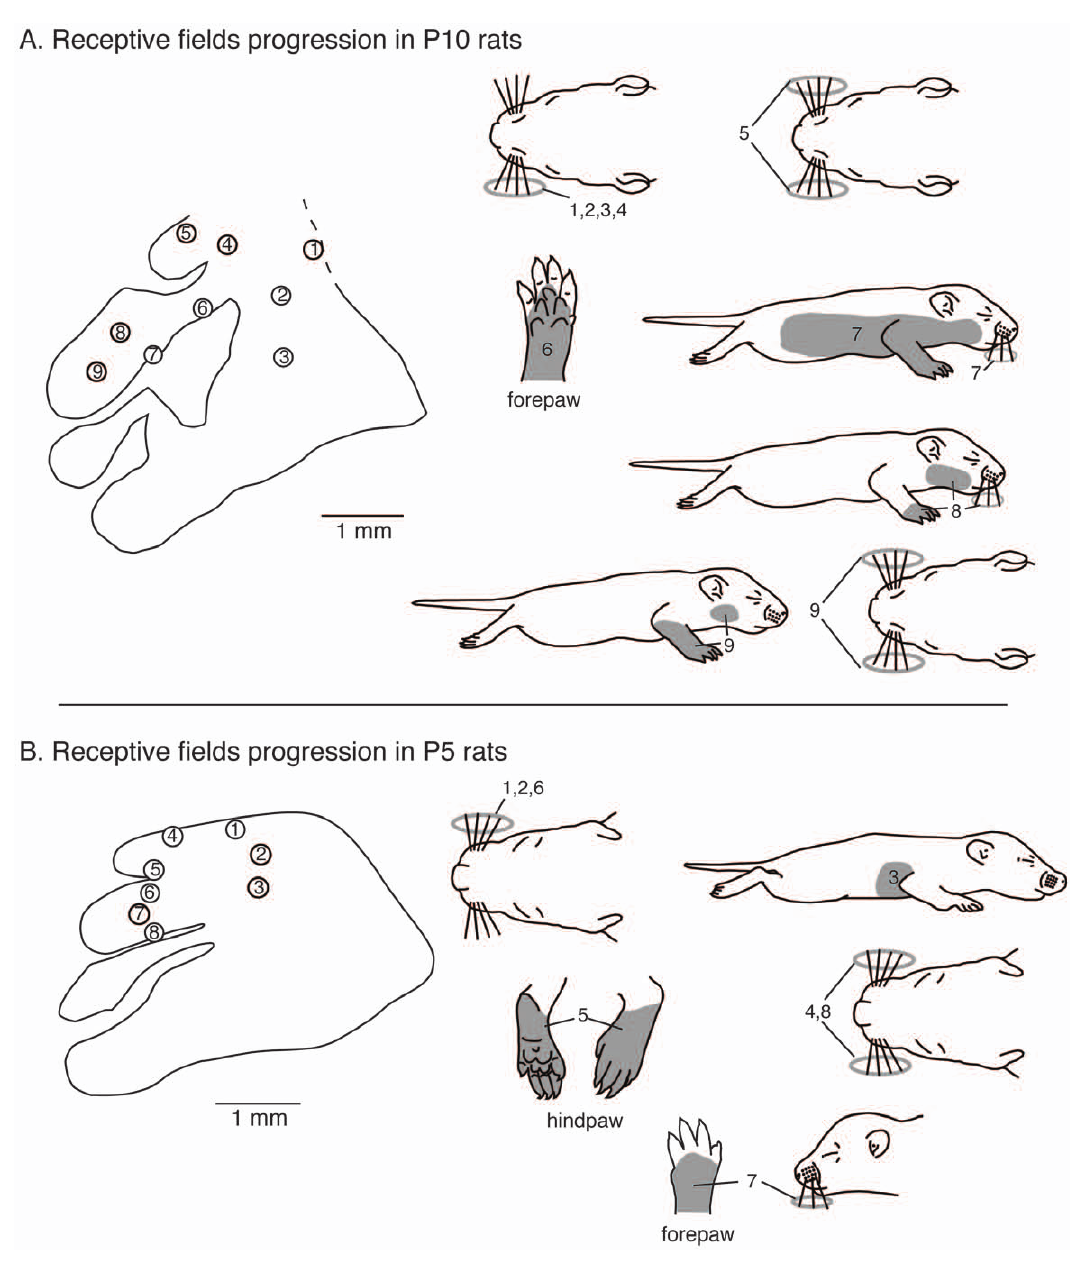
Figure 13. Receptive field progressions in P10 and P5 rats. A) Progressions of recording sites in S1 in a P10 rat (left) and corresponding receptive fields for neurons at those sites (right). In P10 rats, the topographic organization is imprecise. The receptive fields are very large and many receptive fields cover multiple body parts (i.e., sites 7–9). Vibrissae representations are found throughout S1 in inappropriate locations (i.e., sites 1, 2, 4 and 5). As recording sites progress from medial to lateral in the caudal portion of S1 (1–3) corresponding receptive fields were all on the ipsilateral vibrissae. Recording sites in the far medial location (4, 5), in what would be the hindpaw representation in the adult, had receptive fields on the ipsilateral or vibrissae. Recording sites in medial portions of S1 in what would normally be the forepaw representation (6–9) had receptive fields on the forepaw, split receptive fields on the upper body and vibrissae, bilateral vibrissae and face and vibrissae. B) Progressions of recording sites in S1 in a P5 rat (left) and corresponding receptive fields for neurons at those sites (right). In P5 rats there is no apparent topography. Receptive fields are large, and, when present on the limbs, encompass both hairy and glabrous portions of the paws. Receptive fields are also observed on both the contralateral and ipsilateral body parts. Vibrissae representations are prevalent and found throughout S1. As recording sites progress from medial to lateral in the caudal portion of S1 (1–3) corresponding receptive fields move from the contralateral vibrissae to the lateral trunk. Far medial recording sites (4–5) in what would normally be the hindpaw representation had receptive field on the vibrissae, and in one instance the dorsal and ventral hindpaw. More medial recording sites (6–8), in what would normally be the forepaw representation had receptive fields on the contralateral or bilateral vibrissae, and wrist and vibrissae. Compare this figure with the full map of the body illustrated in Figure 1. Conventions as in previous figures.